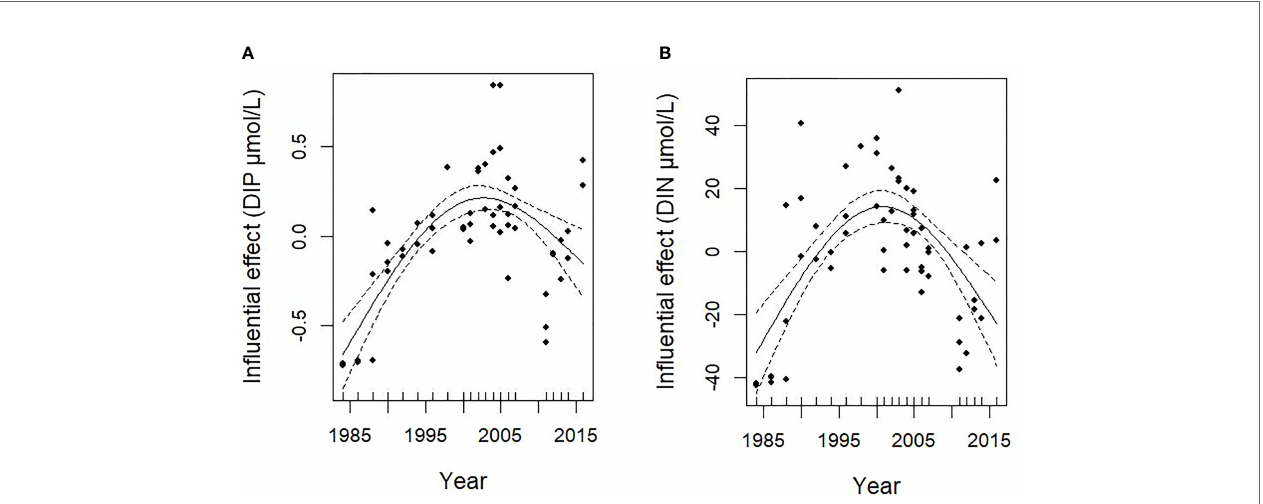
FIGURE 2 | Analysis of nutrients concentrations for (A) DIN and (B) DIP in the mixing zone of the Changjiang River Estuary during 1984 to 2016 based on generalized additive model. For the location of the mixing zone see Figure 1